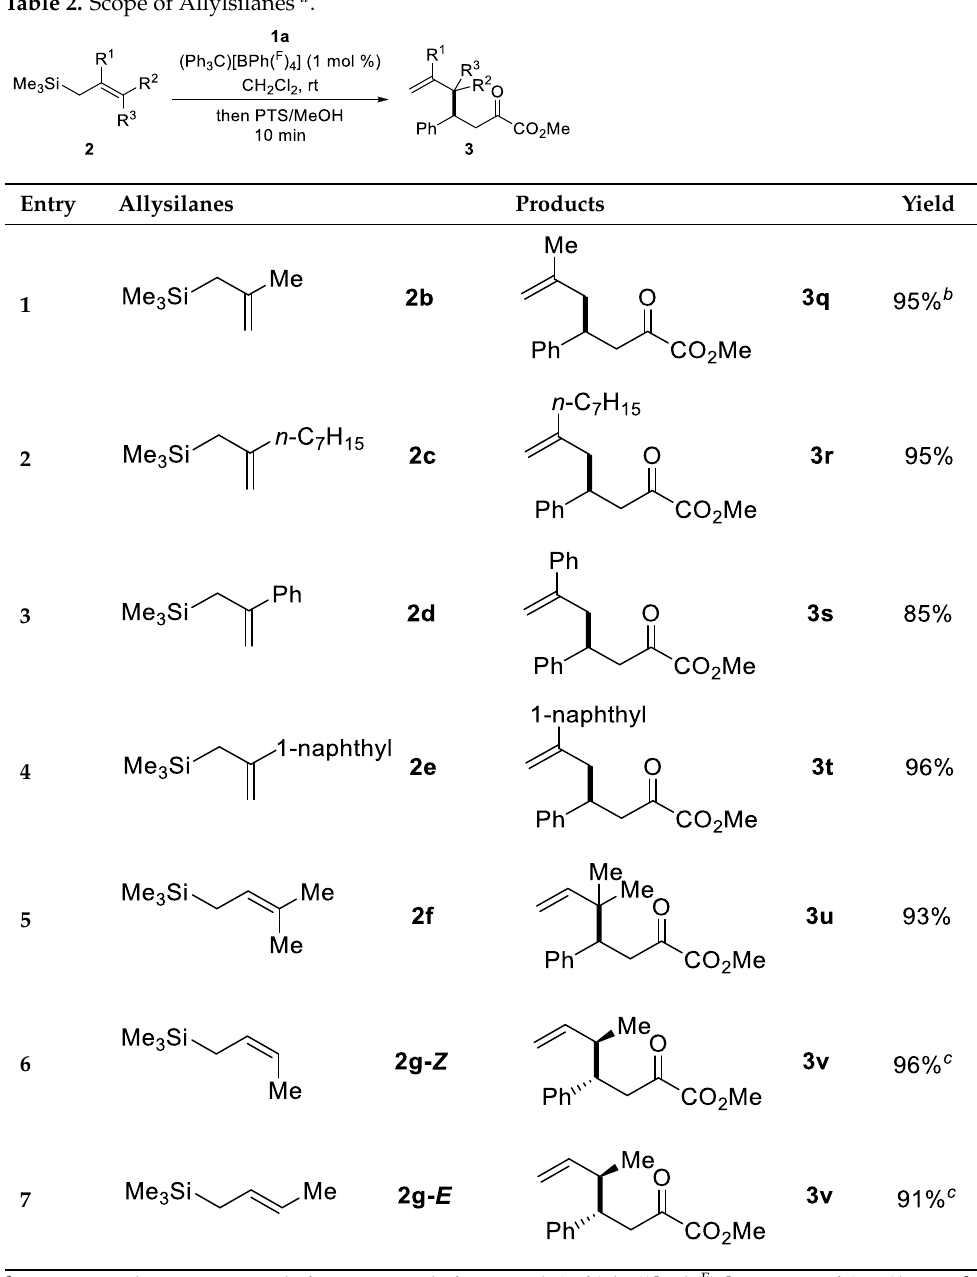
Table 2. Scope of Allylsilanes a .